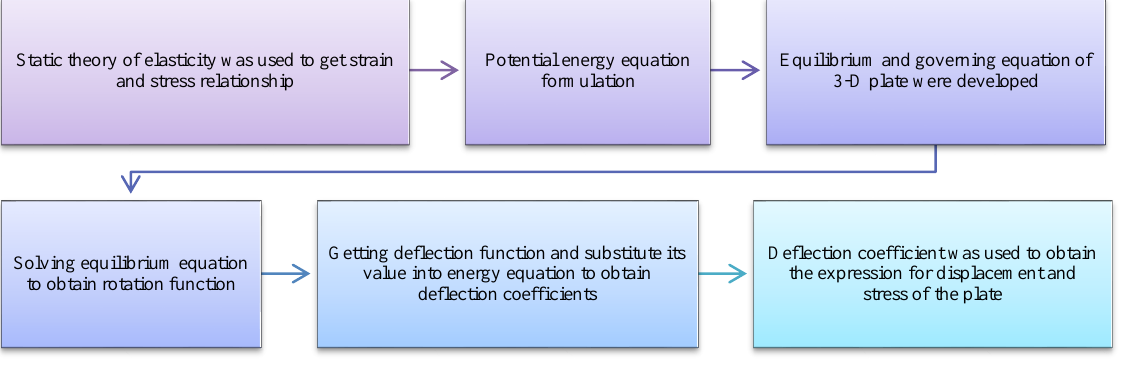
Figure 2. Flowchart to the article analysis procedure as presented in the research methodology